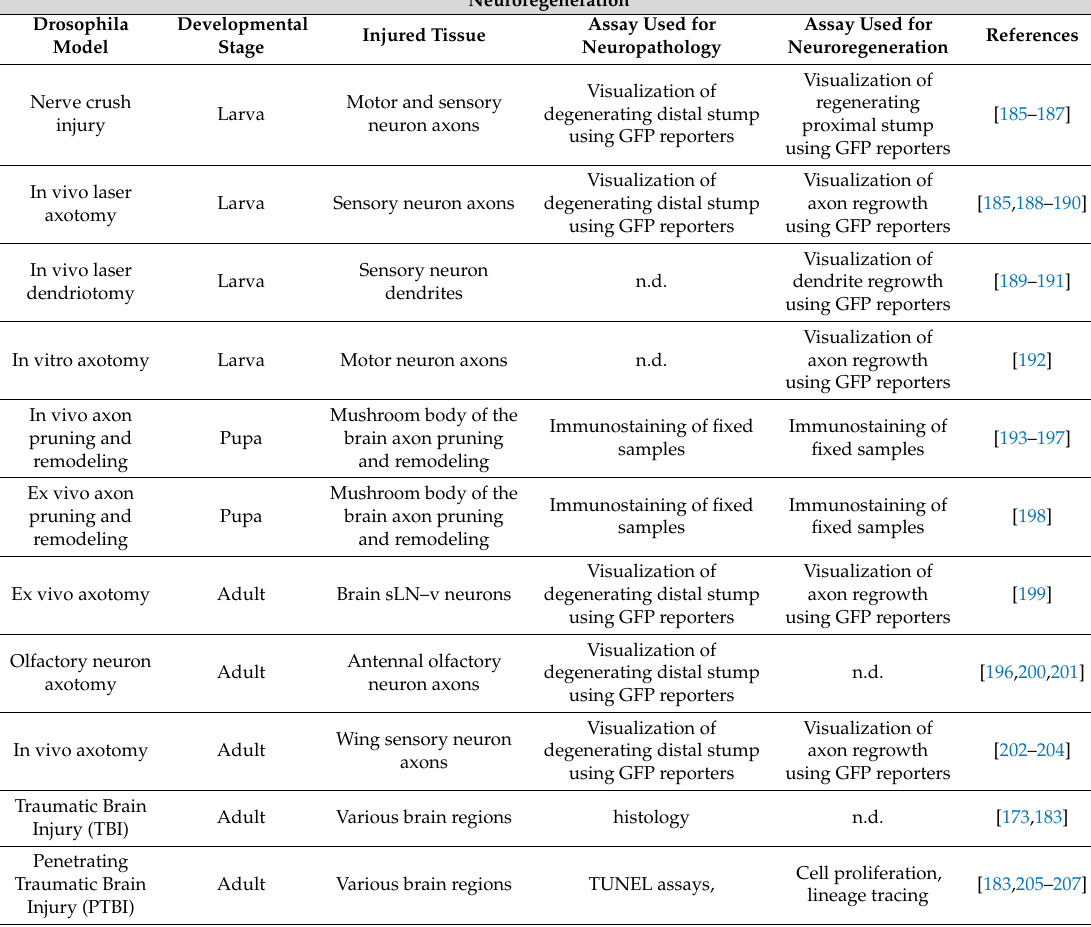
Table 9. Drosophila models of